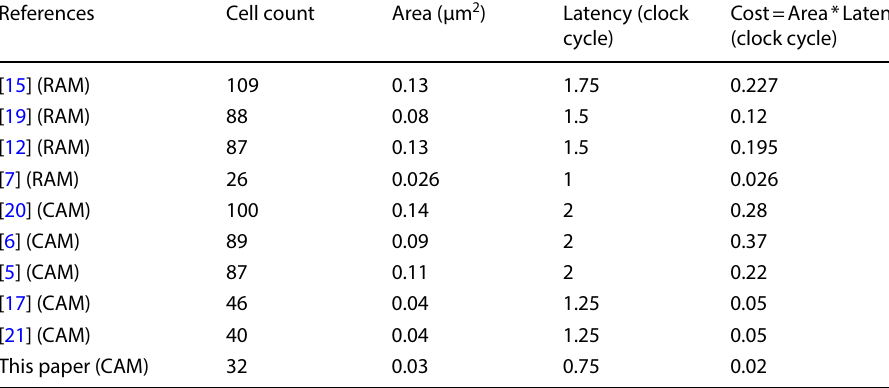
Table 4 The comparative table for the CAM